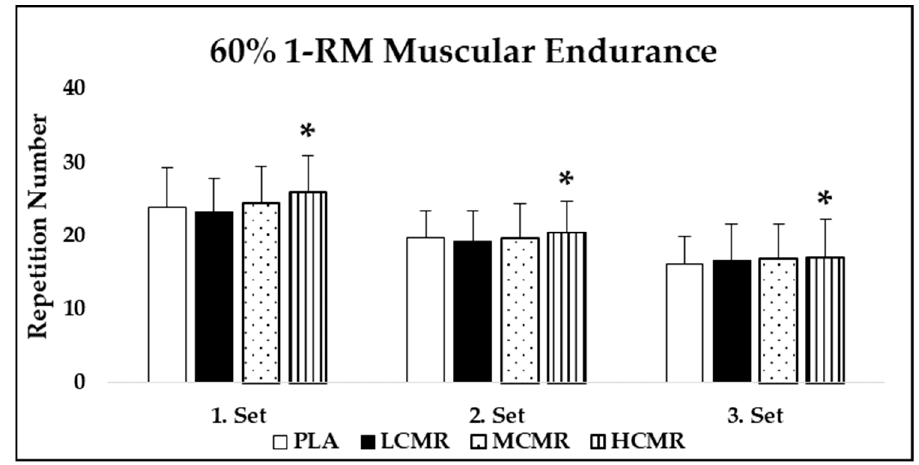
Figure 3. Mean (SD) 60% of 1-RM endurance performance. PLA: placebo; LCMR: low dose of caffeine mouth rinse; MCMR: moderate dose of caffeine mouth rinse; HCMR: high dose of caffeine mouth rinse. *: Significantly different from PLA and LCMR.